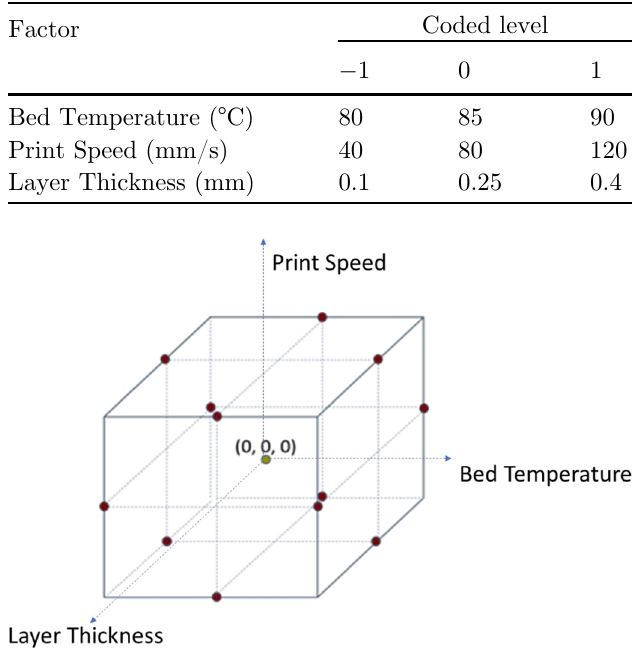
Fig. 4. Graphical representation of Box-Behnken design